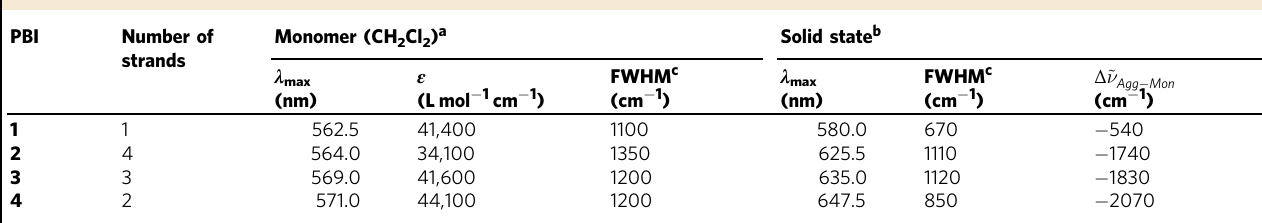
Table 2 Optical properties of the PBIs in solution and solid state PBI Number of